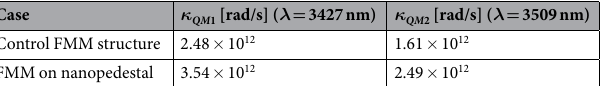
Table 2. Mode coupling coefficients obtained from the theoretical fitting of the data shown in Fig. 5 for the two FMM structures at the two ODT vibrational